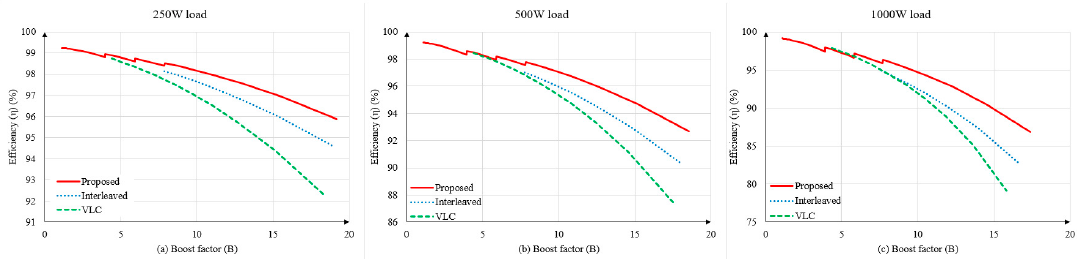
Figure 12. The comparison of efficiency between the proposed converter and the others in Figure 2a,b with Po = 250 W ( a ), 500 W ( b ), and 1000 W ( c ).